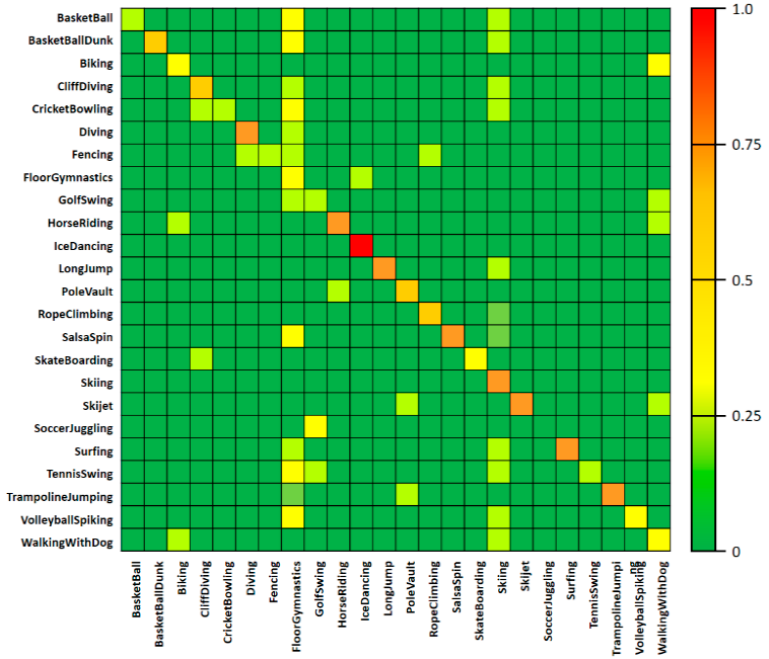
Figure 7. Confusion matrix for actions; UCF-101.